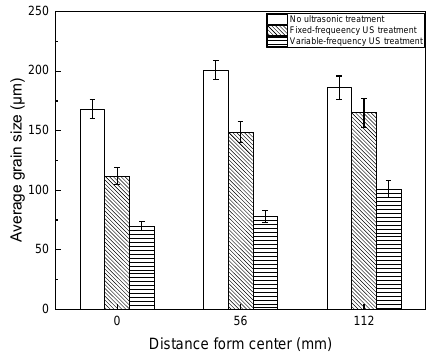
Figure 7. Average grain size of ZK60 alloys with different ultrasonic treatments.